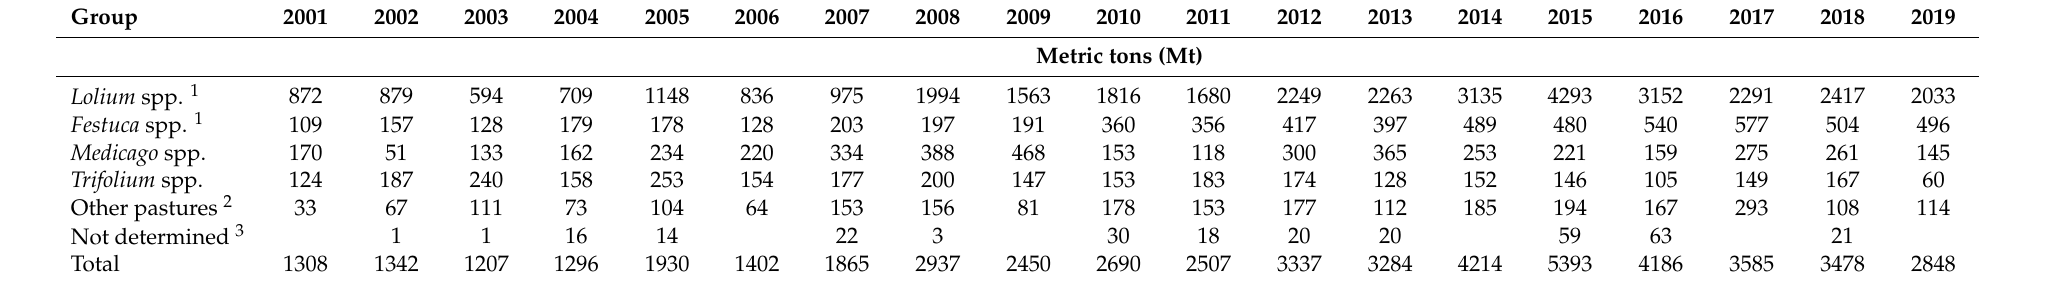
Table 1. Total pasture and related turfgrass seed imported (Mt) by group from 2001 to